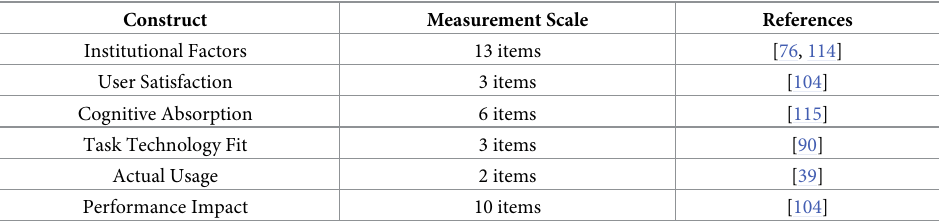
Table 2. Measurement scales and corresponding references for all the constructs.